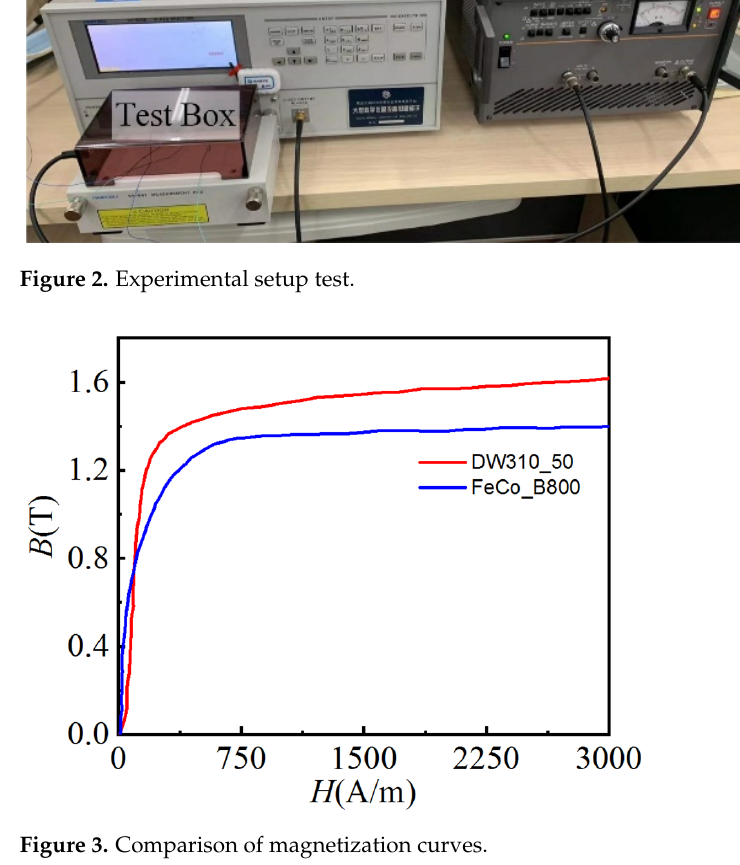
Figure 3. Comparison of magnetization curves.